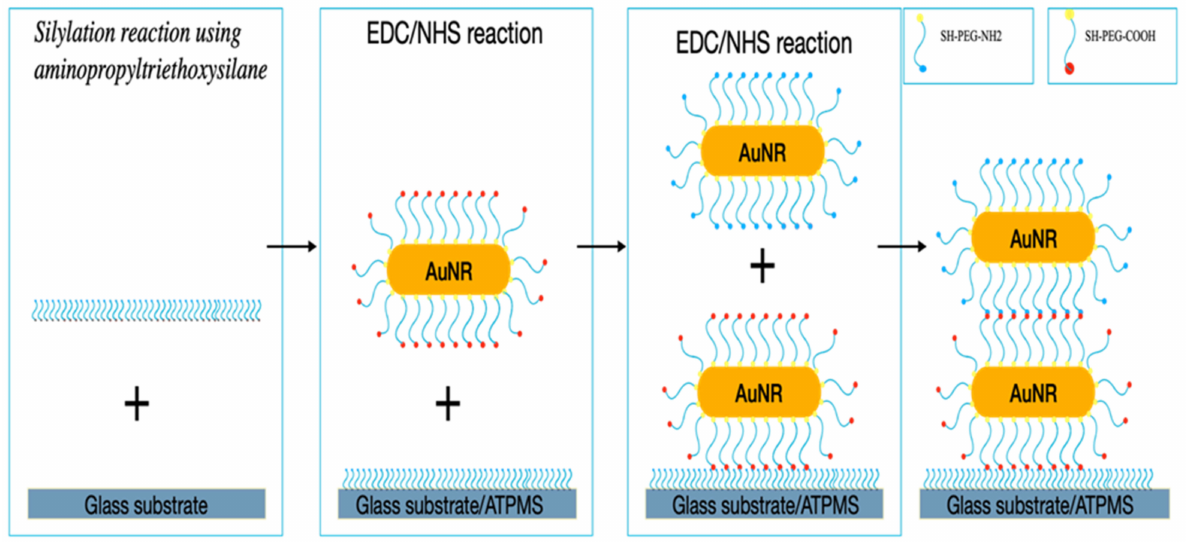
Figure 1. Illustration of the procedures used to produce the AuNR